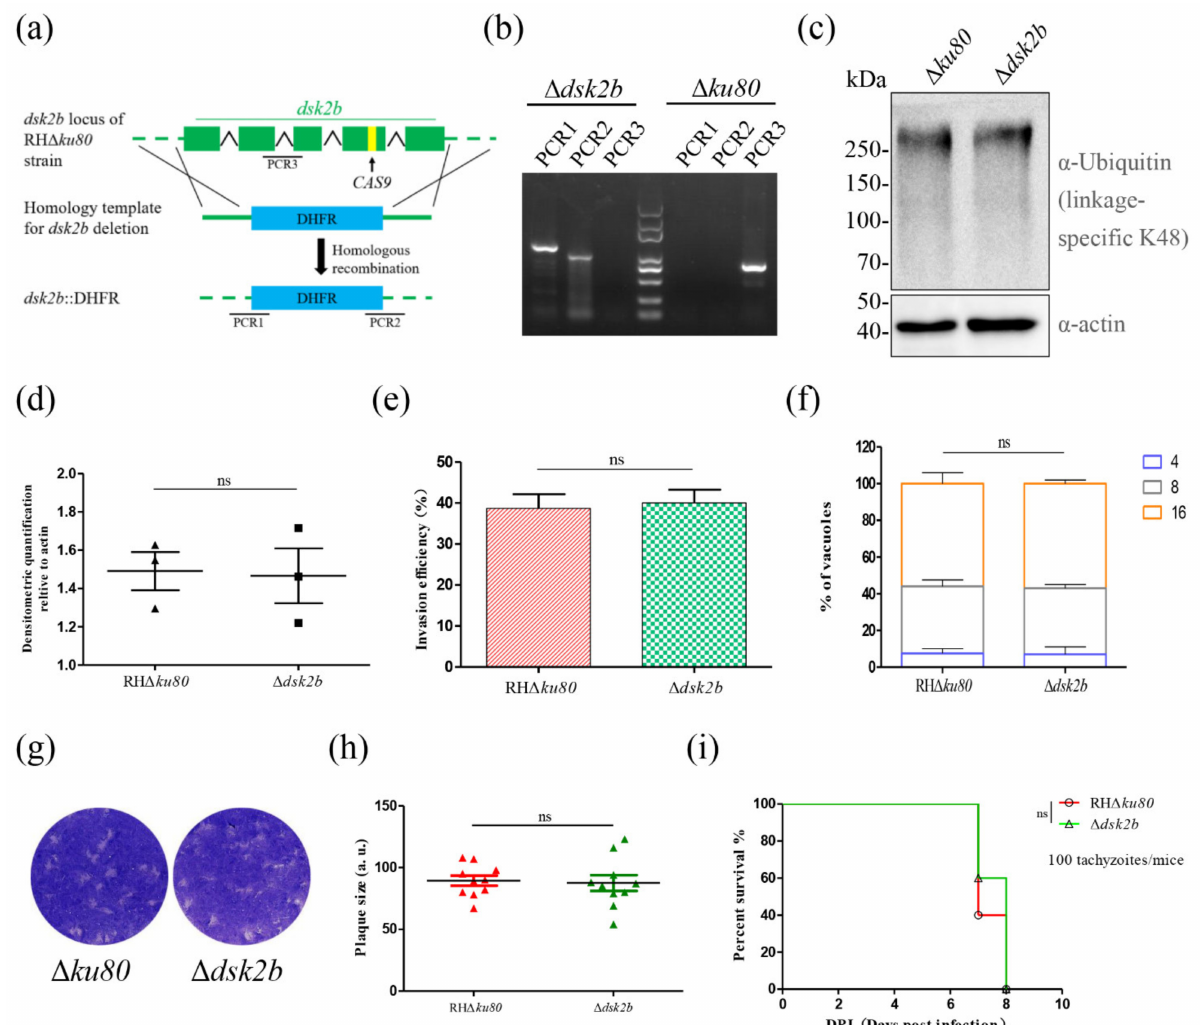
Figure 3. Deletion of DSK2b did not affect the degradation of ubiquitinated proteins and parasite growth. ( a ) Schematic representation of ∆ dsk2b construction. The dsk2b gene locus in RH ∆ ku80 strain was replaced by DHFR cassette. ( b ) Diagnostic PCR of dsk2b deletion. The PCR1 and PCR2 suggest successfully homologous integration. PCR3 amplified the fragment of dsk2b . ( c , d ) Western blotting determined the ubiquitinated proteins in ∆ dsk2b and ∆ ku80 . Ubiquitinated proteins were detected by rabbit anti-ubiquitin (linkage-specific K48) monoclonal antibody (upper panel). Actin served as a loading control (bottom panel). Graphs represent densitometric relative to actin (mean ± SD from three biologically independent experiments); ns: not significant. ( e ) Invasion assay of ∆ dsk2b and ∆ ku80 strains. IFA was performed after invasion for 30 min. Tachyzoites and host cells were counted in several random fields under a fluorescence microscope, and the invasion efficiency was calculated. Graph represents mean ± SEM for three independent experiments. ( f ) Replication assay of ∆ dsk2b and ∆ ku80 strains. IFA was performed after growth in HFF cells for 24 h. Anti-GAP45 antibody was used to stain parasites. Tachyzoites were counted in 100 PVs. Data represents mean ± SEM for two independent experiments. ( g , h ) Plaque formation of ∆ dsk2b and ∆ ku80 strains. A total of 500 tachyzoites were inoculated in HFFs for 7 days and then stained with crystal violet ( g ). Quantification of plaque sizes ( h ). 10 plaques were quantified; ns: not significant. ( i ) Survival curve of BALB/c mice intraperitoneally injected with 100 tachyzoites of ∆ dsk2b or ∆ ku80 strain for 8 days. The function of a UBL-UBA shuttle protein is to transfer ubiquitinated proteins to the proteasome for degradation. Thus, we detected the K48-linked polyubiquitin chains (a modification associated with directing ubiquitin-mediated protein turnover) in ∆ dsk2b by Western blotting. The results showed that the ubiquitinated proteins in ∆ dsk2b were not affected (Figure 3c,d). An invasion assay, replication assay and plaque assay showed that the deletion of dsk2b did not affect the invasion and growth of T. gondii (Figure